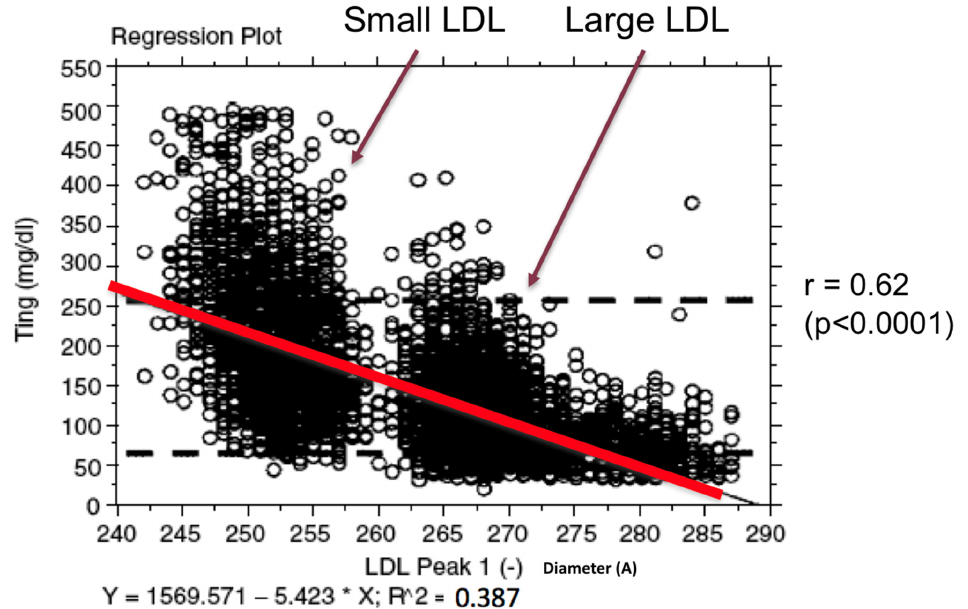
Figure 2. Scatter-plot of fasting triglycerides and LDL peak particle diameter in angstroms ( r = 0.62, p < 0.0001) in 5366 CHD patients seen at the Fuqua Heart Center in Atlanta, Georgia. Large LDL particles have a diameter ≥ 263 angstroms and small LDL particles a diameter ≤ 257 ang ‐ stroms. Thus, assuming fasting triglycerides < 150 mg/dL reflects the absence of small LDL can be an error in approximately 27% of patients. Most recently, a new small LDL pre ‐ diction equation, based on standard lipid panel results, has been proposed to enhance CHD risk estimation [17]. 4. Evidence for LDL Heterogeneity Association with CHD Risk Identification of a group of individuals with an abundance of small, dense LDL identifies individuals that carry a significantly increased CHD risk [18]. An abundance of small, dense LDL particles is a common finding in the CHD patient population, with 30–40% of CHD patients expressing an abundance of small LDL. In the Quebec Cardio ‐ vascular Study, statistical adjustment for LDL ‐ C, triglycerides, HDL ‐ C, and apoB had virtually no impact on the relationship of small LDL and CHD risk [19]. However, the presence of other risk factors, such as elevated Apo B, magnified the risk associated with small, dense LDL. The increased CHD risk associated with an abundance of small, dense LDL has been reported, consistently and reproducibly, in the Boston Area Heart study, the Stanford Five City project, the Harvard Physicians Health Study, the Quebec Cardi ‐ ovascular study, and the Women’s Health Study, among others (Table 1) [18,20–23]. Rel ‐ atively recent clinical trial reports have confirmed the atherogenicity of small LDL in the Malmo Heart Study in 2009, as well as the Atherosclerosis Risk in Communities (ARIC) and the Multi ‐ Ethnic Study of Atherosclerosis (MESA), both in 2014 [24–26]. Indeed, nontraditional markers of cardiovascular disease risk may improve the 2013 American College of Cardiology/American Heart Association guidelines [27].